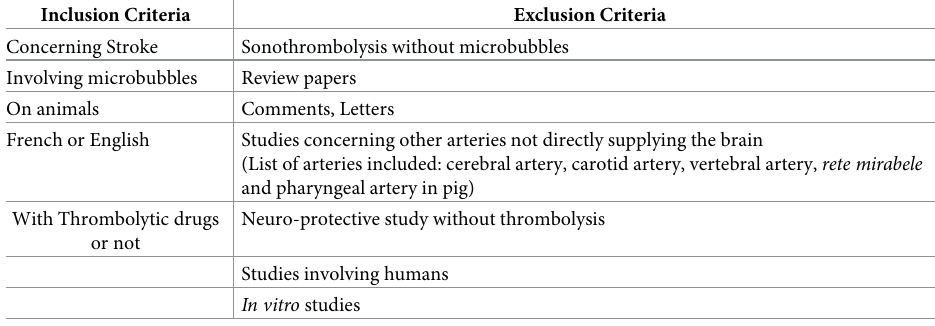
Table 1. Inclusion and exclusion criteria used to select